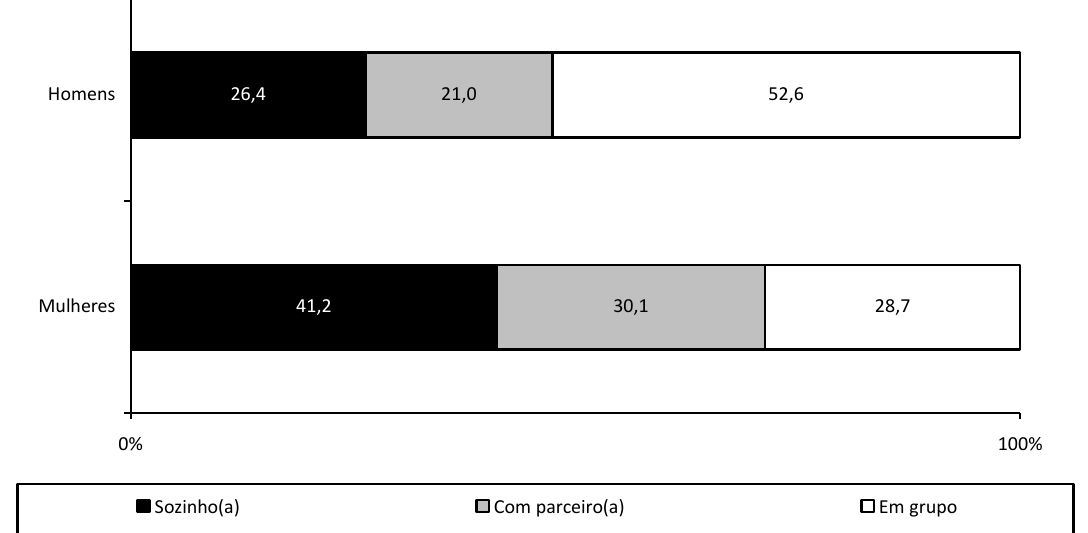
Figura 2. Companhia para a prática de atividades físicas no lazer em homens e mulheres trabalhadores da indústria do Rio Grande do Sul, 2007.